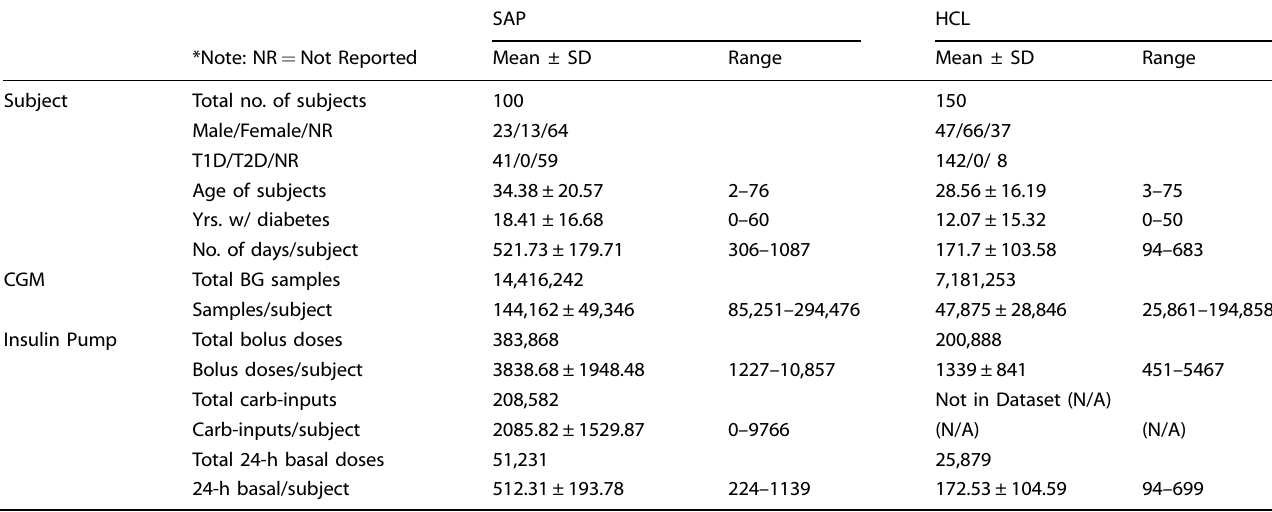
Table 2. Summary of study dataset ( n = 250 subjects with diabetes) including descriptive characteristics of the sensor augmented (SAP) therapy and hybrid closed loop (HCL)